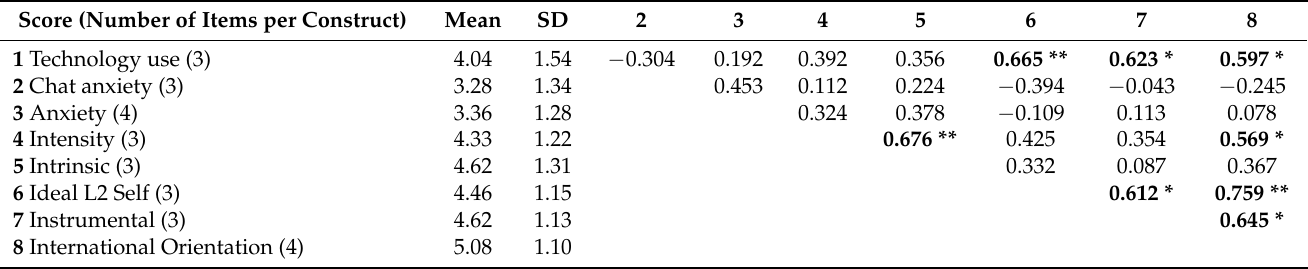
Table 5. Descriptive statistics and Spearman correlations on task motivation and anxiety (1 = strongly disagree–6 = strongly agree) for all participants ( N = 15).